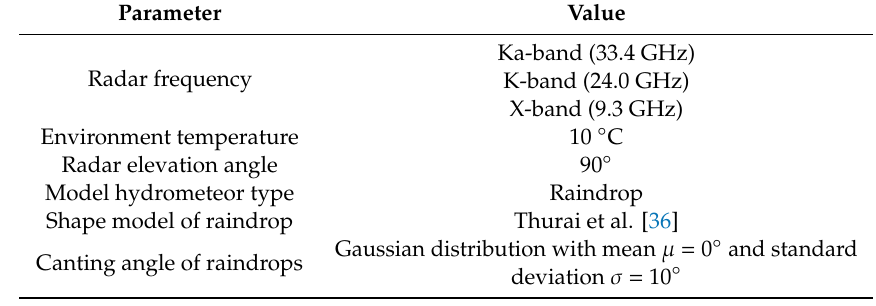
Table 3. Controlled conditions for the T-matrix simulation.